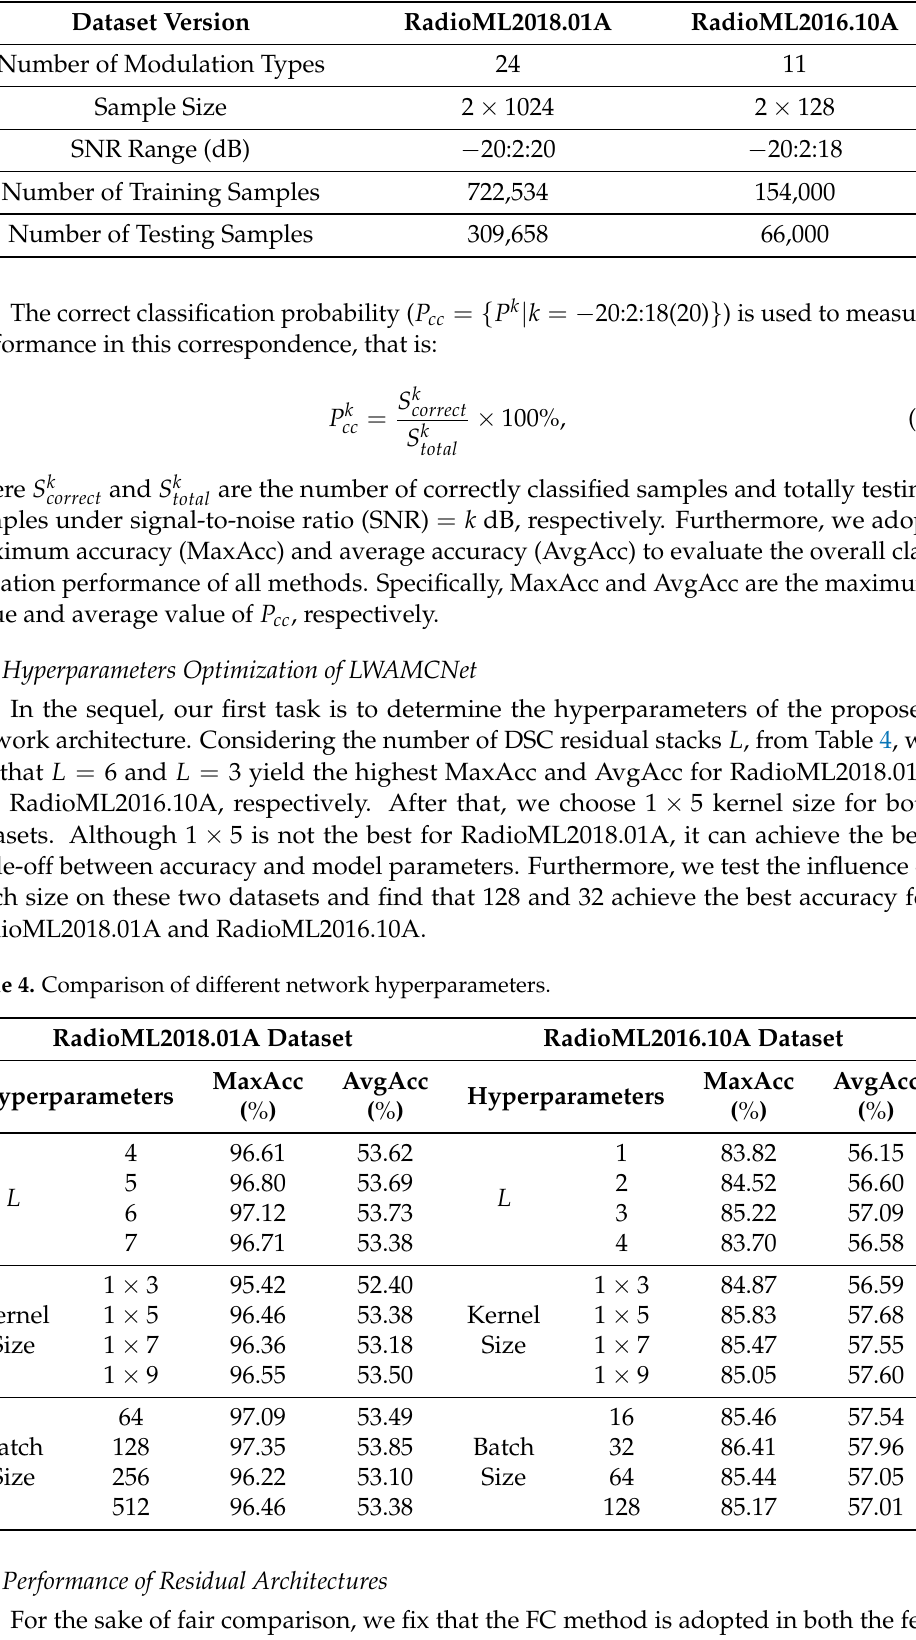
Table 3. RadioML dataset parameters.